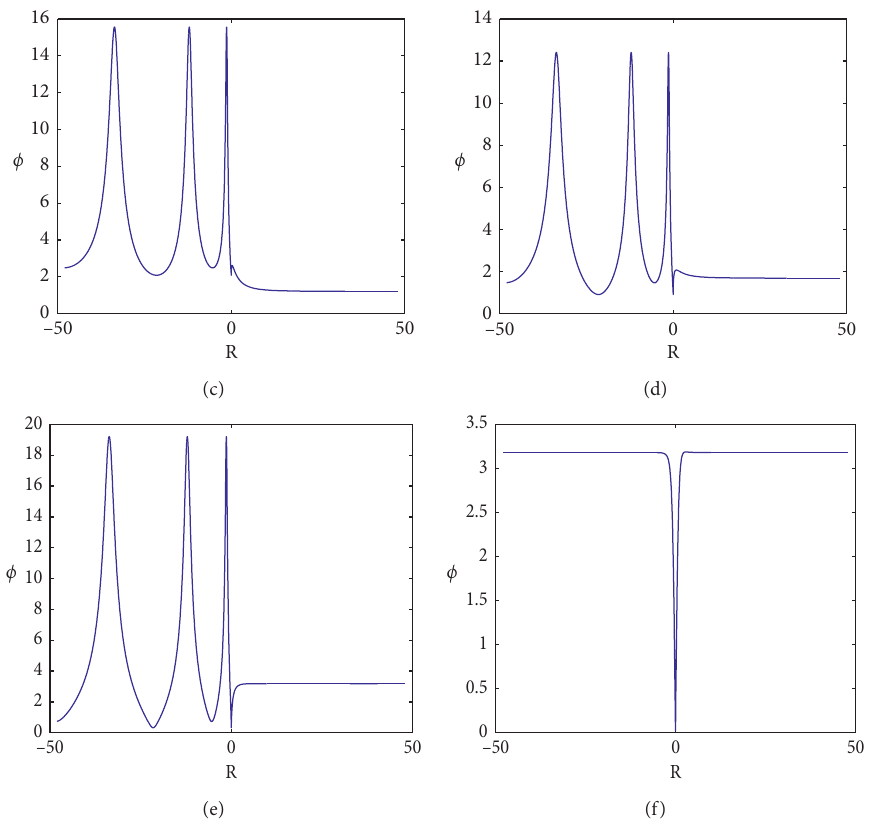
Figure 6: The values of the parameters are as follows. (a) β � 1 . 2, β � 1 . 8, ω � 1, and ϖ � 1. (d) β (c) β 1 3 ω � 1, and ϖ �